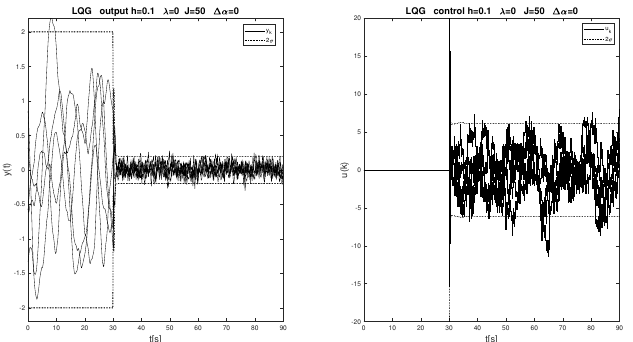
Figure 5. Realization of the output ( left ) and control signal ( right ) for λ = 0 and ∆ α = 0.